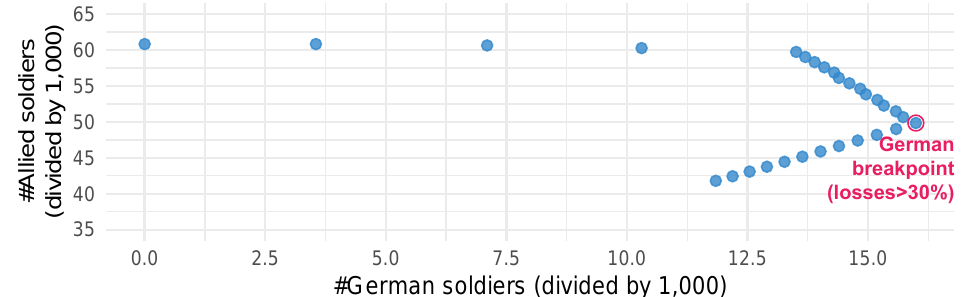
Figure 12. Scatter plot obtained from the predictive block for defensive position and fortified terrain as an alternative course by applying a 1.5:1 ratio for Allied troops. The selected COA prevents the invasion of the island (the German breakpoint on the 8th day defines the Allied victory).